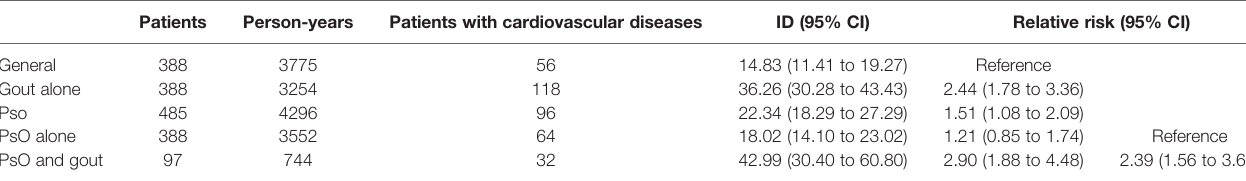
TABLE 2 | Incidence density of cardiovascular diseases among different groups.